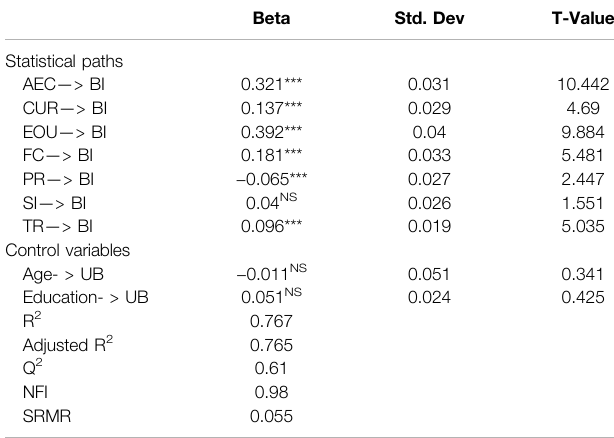
TABLE 4 | Model 1 (Direct path analysis).